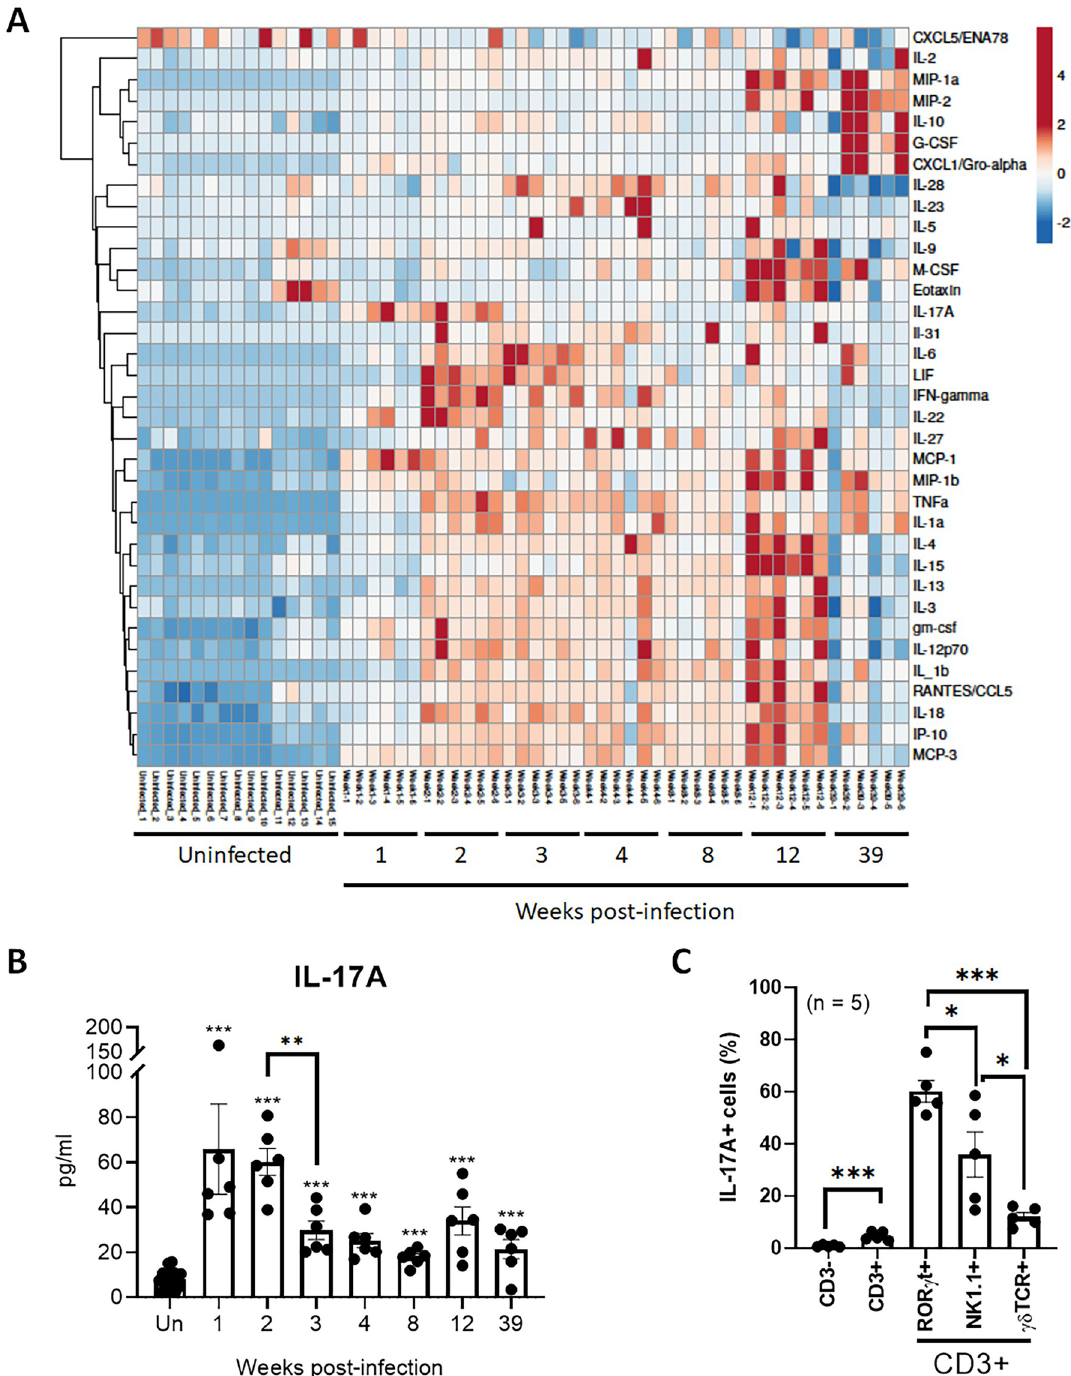
Fig 4. Cytokine and chemokine profiles of M . intracellulare -infected mouse lungs. ( A-B ) Lungs from uninfected control and M . intracellulare -infected mice were collected at 1, 2, 3, 4, 8, 12 and 39 weeks postinfection. Overall, 36 cytokines and chemokines were determined in lung homogenates of mice using multiplex ELISA. Data were pooled from two independent experiments (uninfected mice n = 15, infected mice n = 6 mice per indicated time point), and hierarchical clustering was performed (A). The IL-17A level at each time point is shown (B). ( C ) To identify the cellular source of IL-17A, lung cells were isolated from M . intracellulare -infected mice (n = 5) after 2 weeks of infection (because lung IL-17A levels peaked at 1–2 weeks postinfection), and IL-17A-producing cells were determined by flow cytometry. The percentages (%) of IL-17A-producing cells in CD45+CD3- cells, CD45+CD3+ cells, CD45+CD3 +ROR γ t+ cells, CD45+CD3+NK1.1+ cells and CD45+CD3+ γδ TCR+ cells are shown (C). Data are expressed as the means ± SEM.